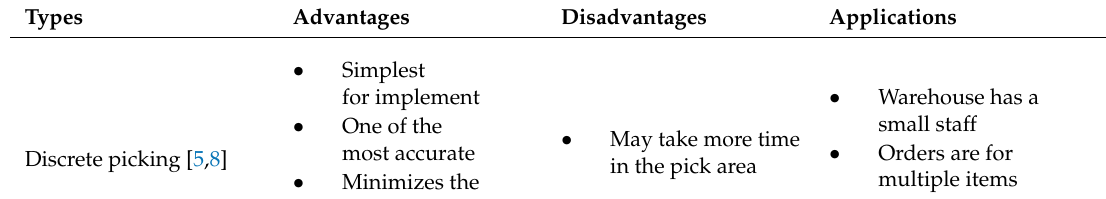
Table 1. Summaries of types of order picking policies or